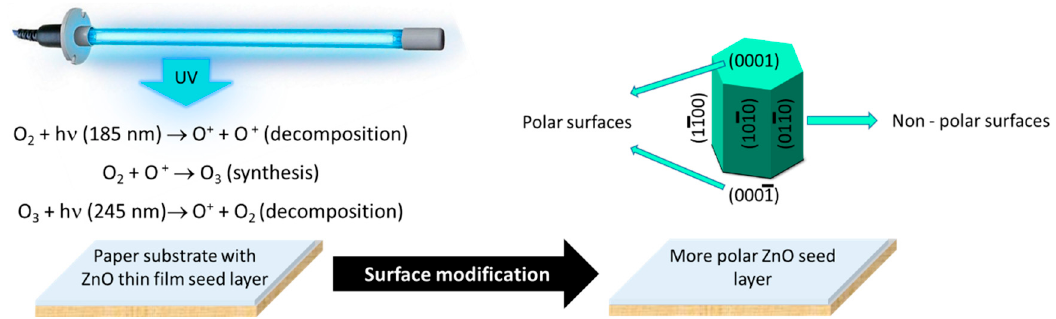
Figure 4. Schematic of surface treatment/modification of ZnO seed layer with an UV/Ozone system.